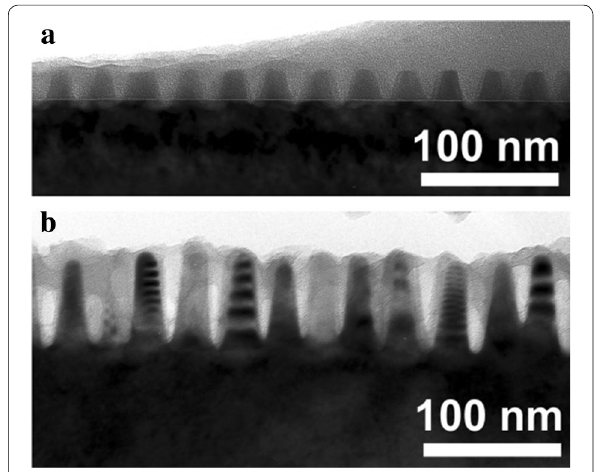
Fig. 11 TEM cross-sectional image of Si nanorods. a Underlying Si